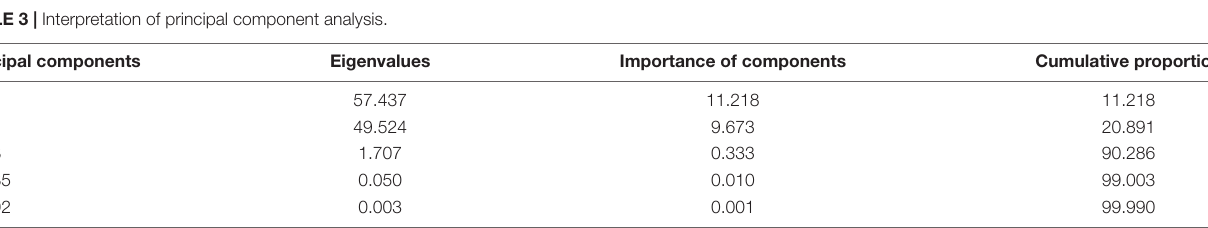
TABLE 3 | Interpretation of principal component